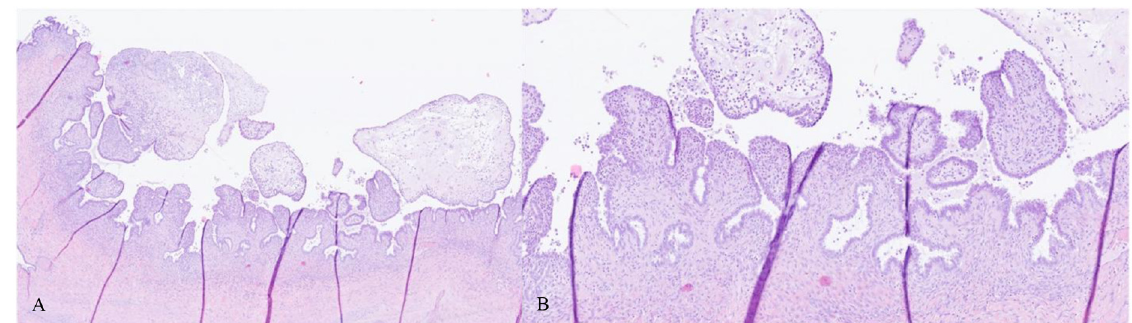
X40.Figure 3. Histologic examination of serous borderline tumor (SBT). Hematoxylin and eosin (H&E) staining, original magnification 3A: X4;